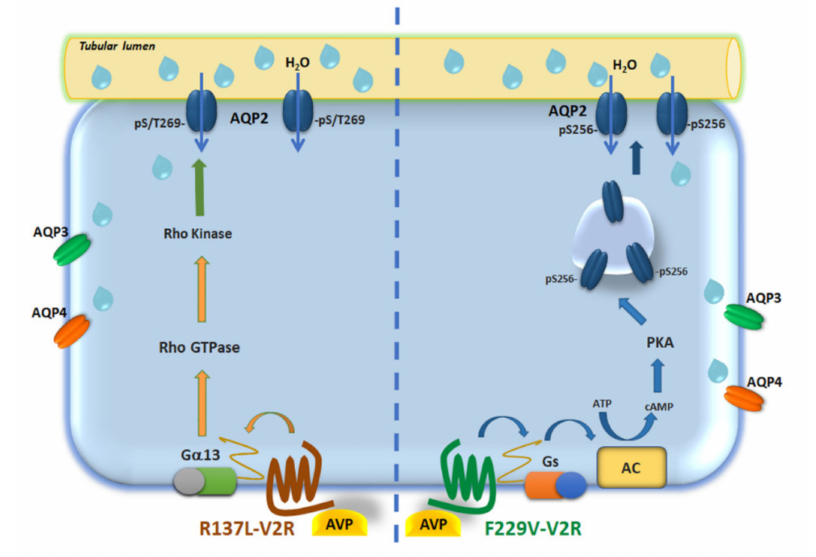
Figure 7. Schematic model depicting two distinct signalings activated by the gain of function V2R-F229V and V2R-R137L causing NSIAD: The gain-of-function mutation R137L signals through an alternative PKA-independent pathway that increases AQP2 membrane targeting through ROCK induced phosphorylation at S / T269 independently of S256 of AQP2. Conversely, V2R-F229V